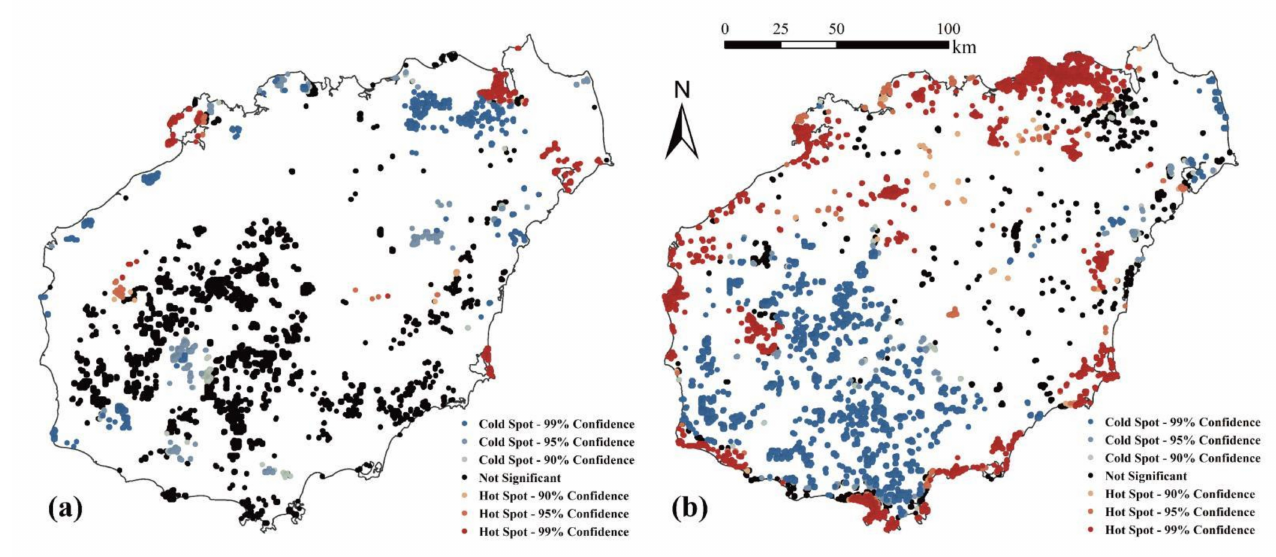
Figure 9. Hotspot distribution of carbon storage change from 1992 to 2019: ( a ) represents an increase in carbon storage, ( b ) represents a decrease in carbon